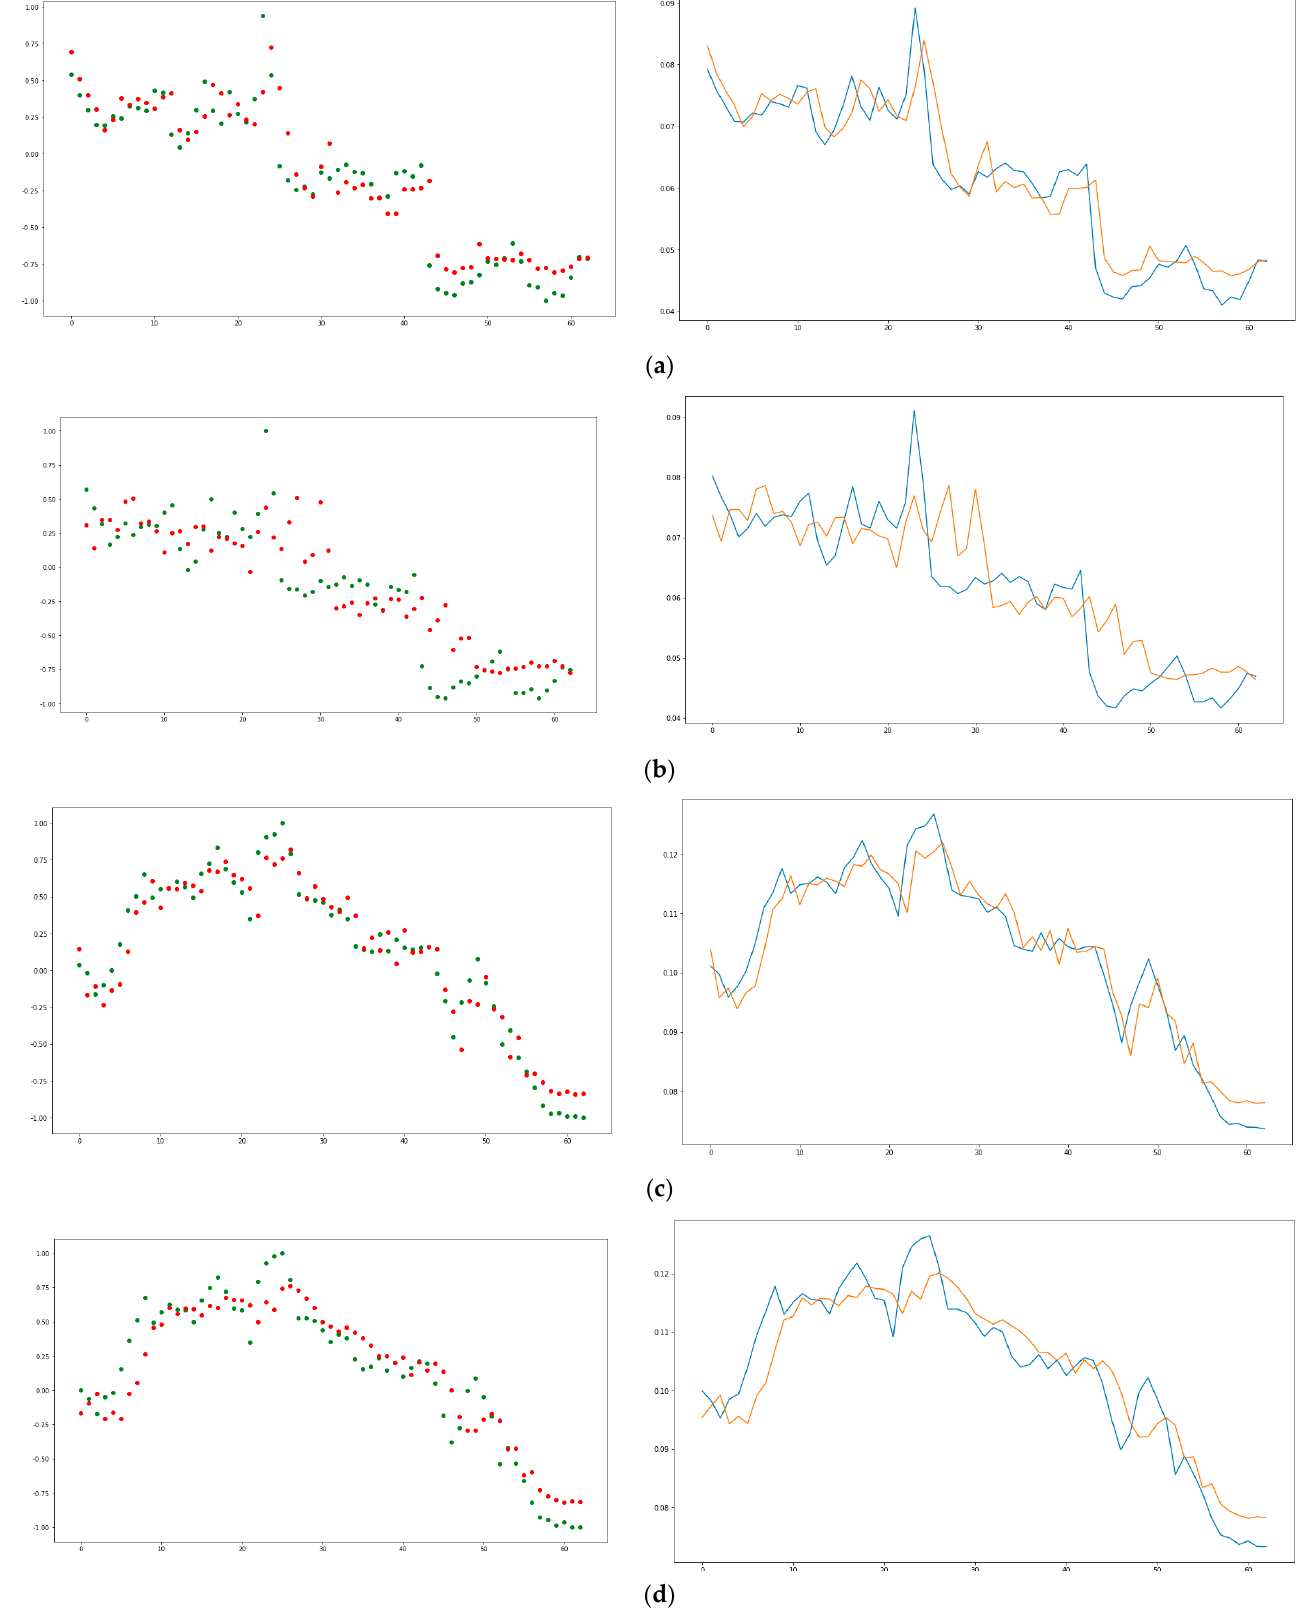
Figure 6. ( a ) Scenario 1 results. ( b ) Scenario 2 results. ( c ) Scenario 3 results. ( d ) Scenario 4 results.